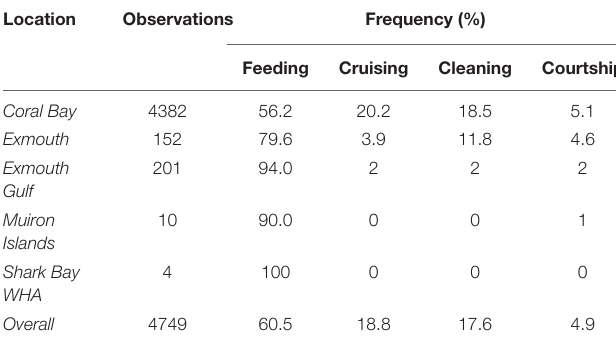
TABLE 5 | Behavioural observations for M. alfredi from photo-ID records at various locations in Western